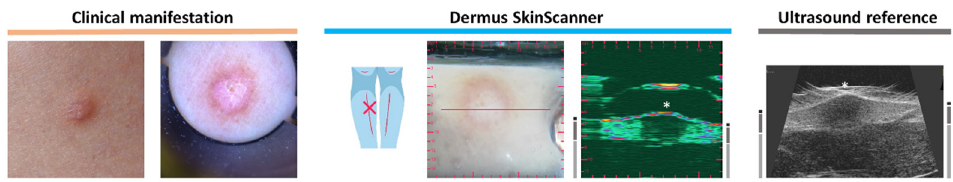
Figure 7. Examination images of a dermatofibroma (see Figure 2 for figure layout and marking information). The ultrasound images show a hypoechoic, heterogeneous lesion in the dermis.